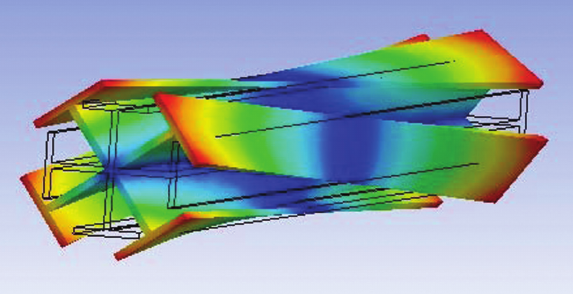
Figure 7 Buckling mode shapes of stiffened cruciform-shaped section for L = 5000 mm (torsional buckling).